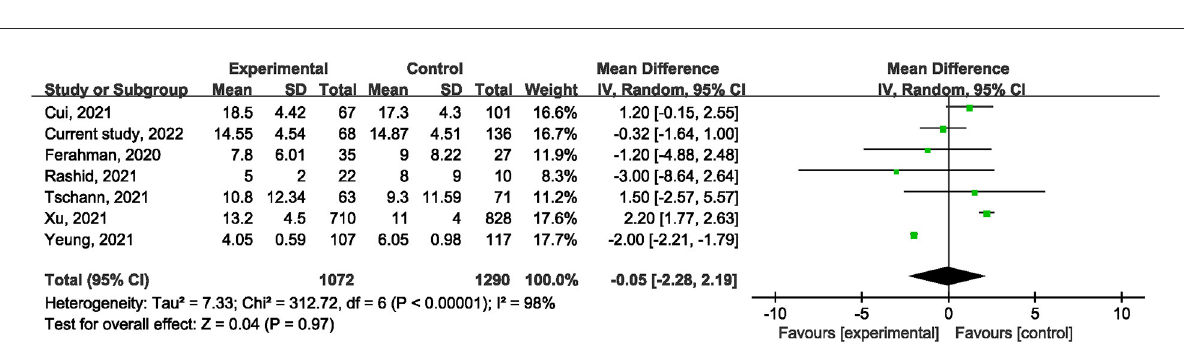
FIGURE8 The impact of the COVID-19 pandemic on the length of hospital